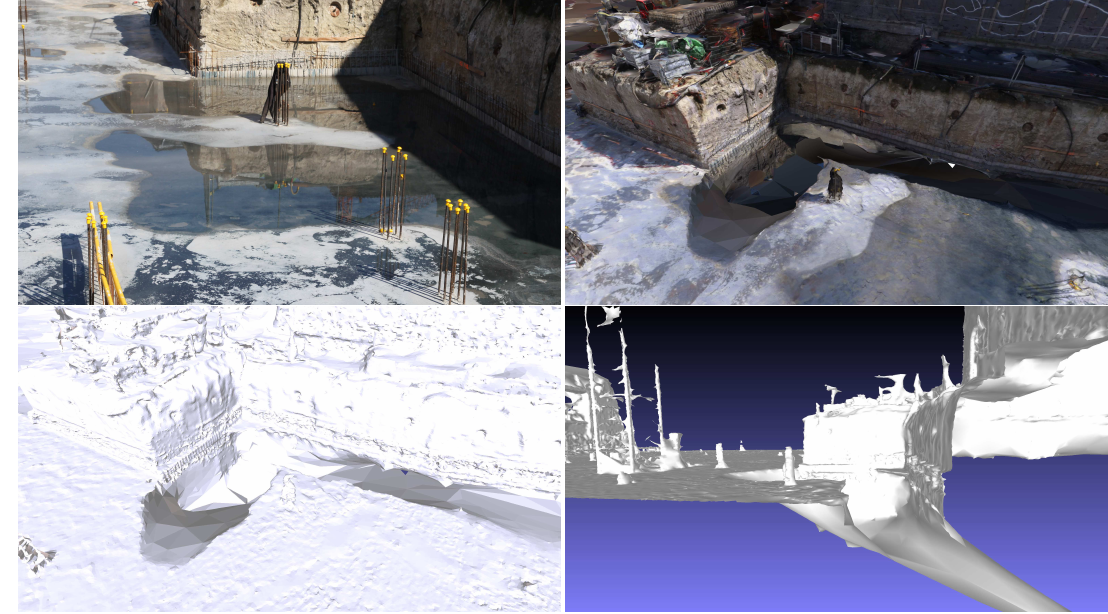
Figure 2: The consequences for the 3D model caused by reflections on the water: recorded image of the construction site with water (top left), textured 3D model (top right), untextured 3D model (bottom left) and side view of the untextured 3D model (bottom right)